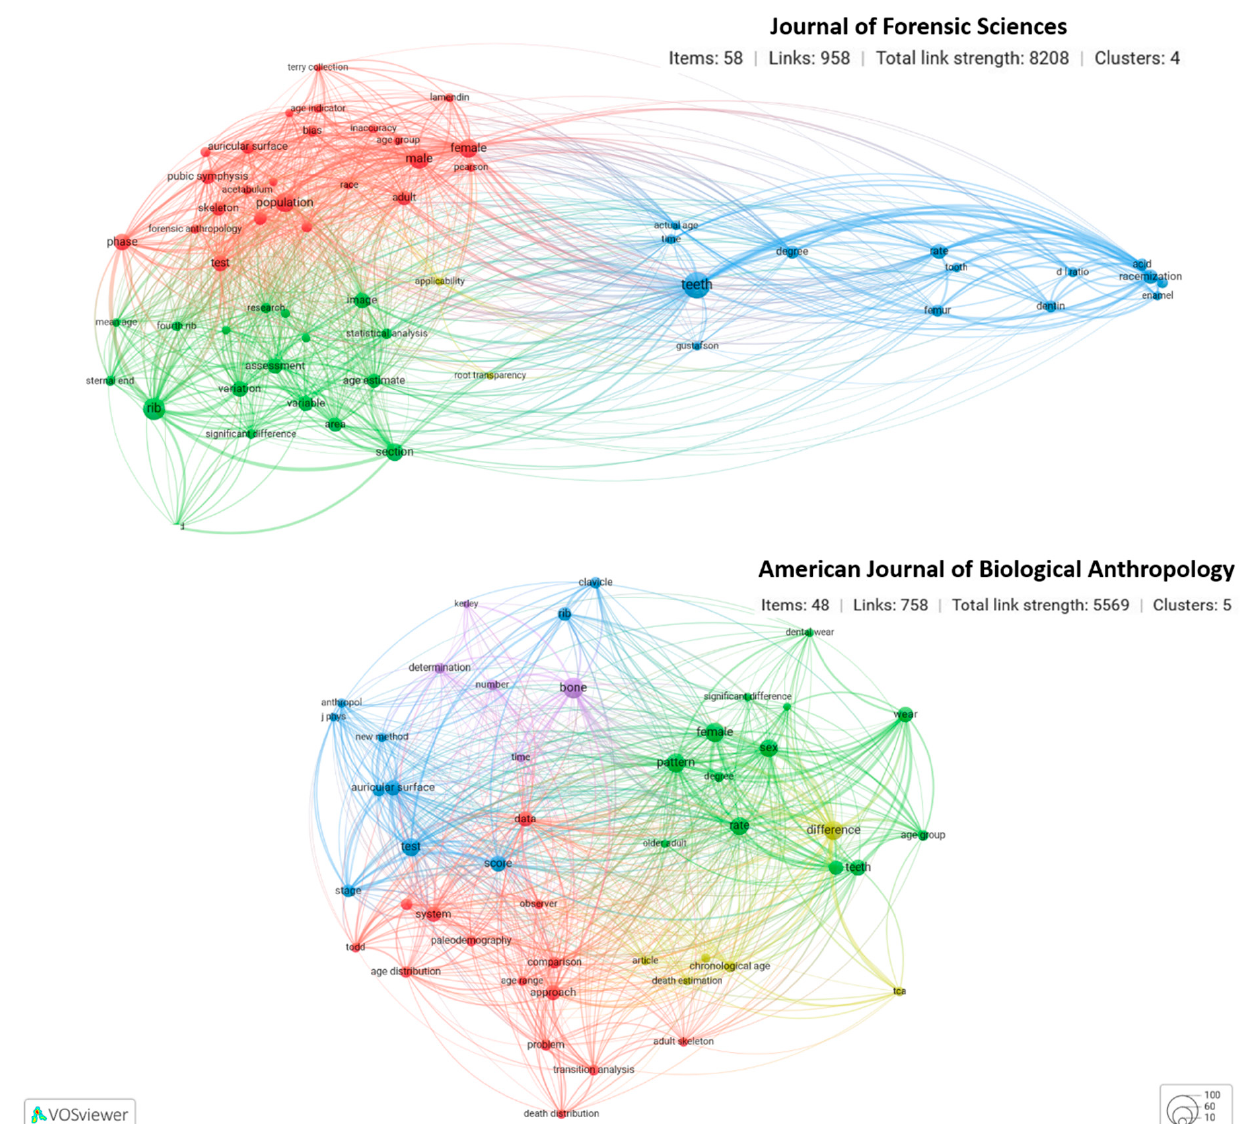
Figure 11. Network visualization for the co-occurrence of terms for the Journal of Forensic Sciences and the American Journal of Biological Anthropology of the TOP4 journals. The interactable maps are accessible at: Journal of Forensic Sciences https://app.vosviewer.com/?json=https://drive.google.com/uc?id=16pEsDcuttezxVFMqVbfvmqtddQaANKR6; American Journal of Biological Anthropology https://app.vosviewer.com/?json=https://drive.google.com/uc?id=10LVG4GlLiRc3WewE98doQ3A Wmo8QO8-e (Accessed on 16 January 2023).